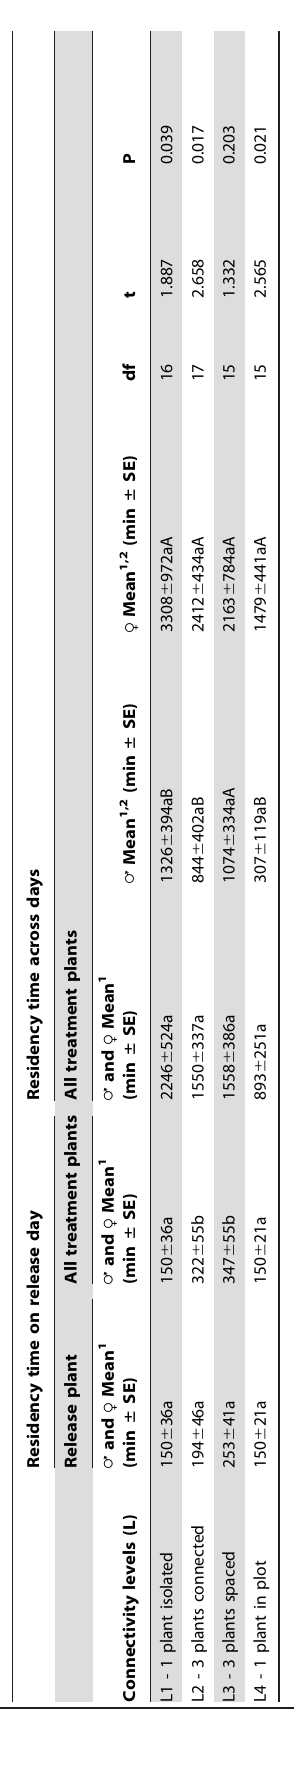
size of the plot: small, 1.83 6 0.12, N= 60; medium, 2.78 6 0.20, N= 71; large, 3.75 6 0.28 meters; N= 92. The exploration (displacement) of the host patch by the beetles over the five day period was proportional to the size of the plot (Y =124.87; X – 233.5; r 2 = 0.87). Between 58 and 65% of total moves were directed away from the borders and this was independent of plot size (Table 4). The proportion of moves directed away from the border or parallel to the border increased sharply as the distance from the border became smaller (Fig. 3) regardless of plot size. None of the tracked beetles that had reached a border row or an end of row plant were observed crossing over to the bare ground surrounding the plots. The proportion of total moves peaked away from crop edges and the proportion of moves away from edges was consistently larger than that of moves towards edges for beetles located at crop edge (Fig. 3). The frequency distribution of turning angles differed from that for a uniform distribution in small ( x 2 = 63.7, df= 5, P , 0.0001), medium ( x 2 = 71.7, df= 5, P , 0.0001) and large ( x 2 = 90.4, df = 5, P , 0.0001) plots (Fig. 4). However, the frequency distribution of turning angles in medium plots and large plots did not differ significantly from that in small plots ( x 2 = 2.4, df = 5, P= 0.788 and x 2 = 9.6, df= 5, P =0.088, respectively). The movement of beetles was characterized by a degree of linearity in successive moves as indicated by the distribution of turning angles. The high frequency of turning angles centered on zero shows that beetles tended to move more or less in one direction and not a random path which would be characterized by a more or less uniform distribution of turning angles. It would correspond to beetles following the edge rows of potato plots in response to the crop border barrier. In addition, it is not uncommon in row crops for walking insects to follow